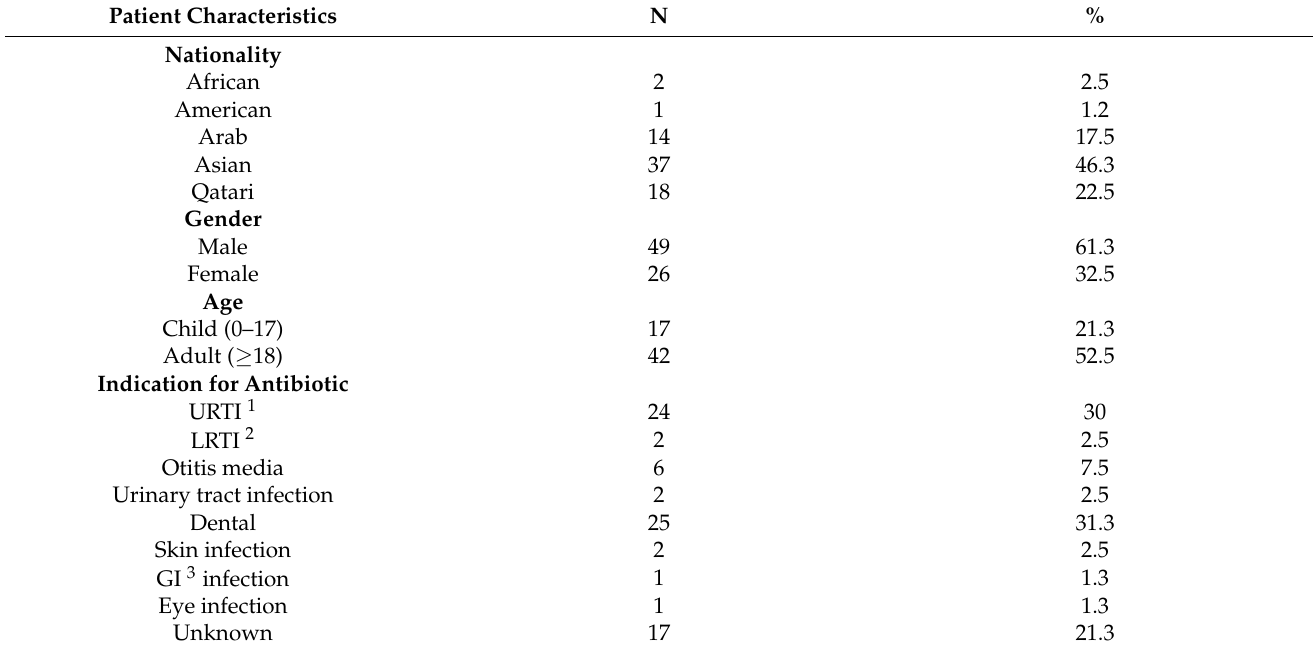
Table 1. Study Participant